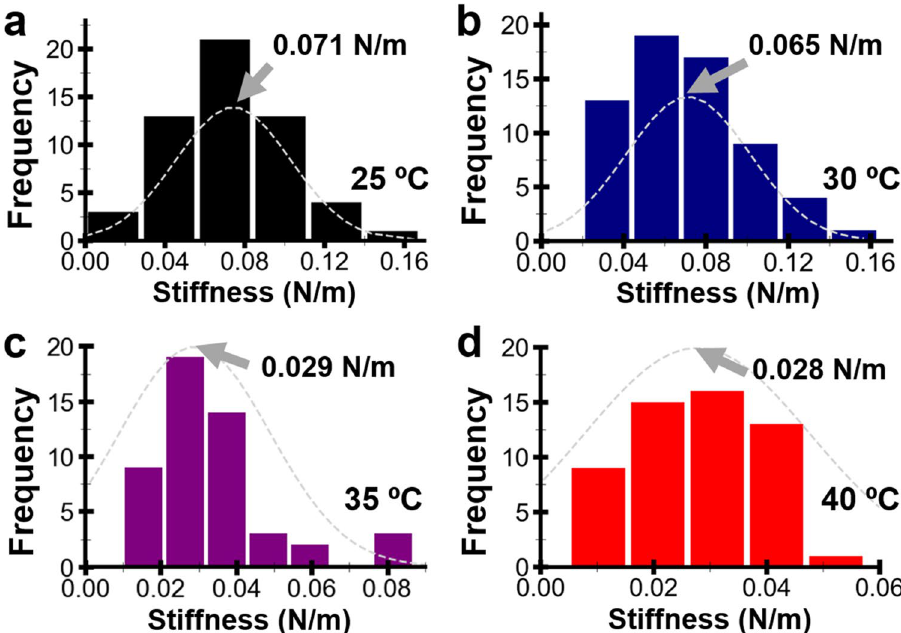
Figure 3. Plots of the stiffness distributions of the C22 phage in MES buffer at 25 ( a ), 30 ( b ), 35 ( c ), and 40 °C ( d ). The dashed grey lines were the normal distribution fitting where the centers (grey arrows) represented the phage stiffness at each temperature.